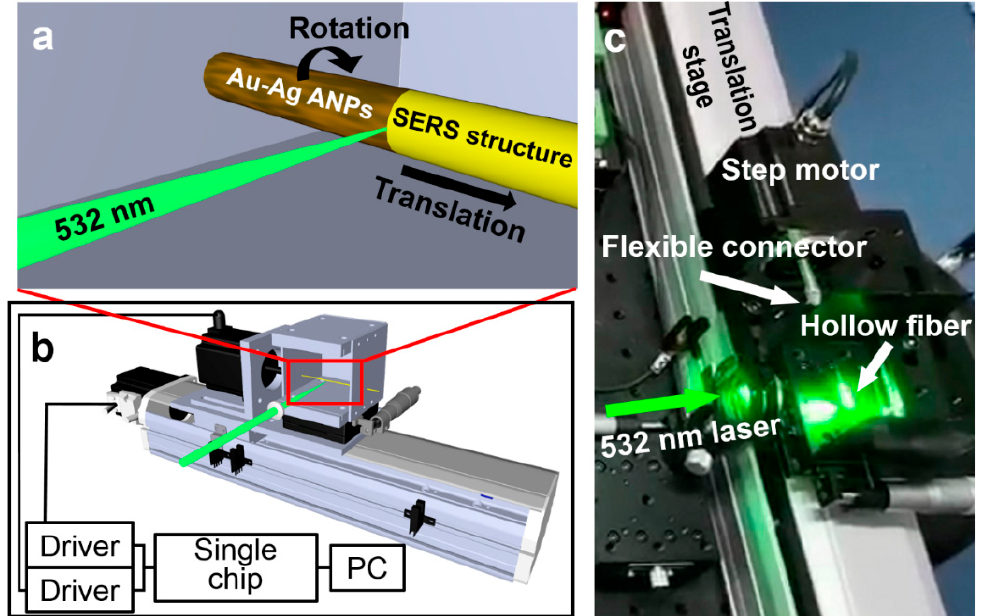
Figure 2. ( a ) Schematic illustration of the principles for direct writing of the SERS hollow fiber. ( b ) The conceptual drawing of the construction of the direct laser writing system. ( c ) Photograph of the home-built DLW system.